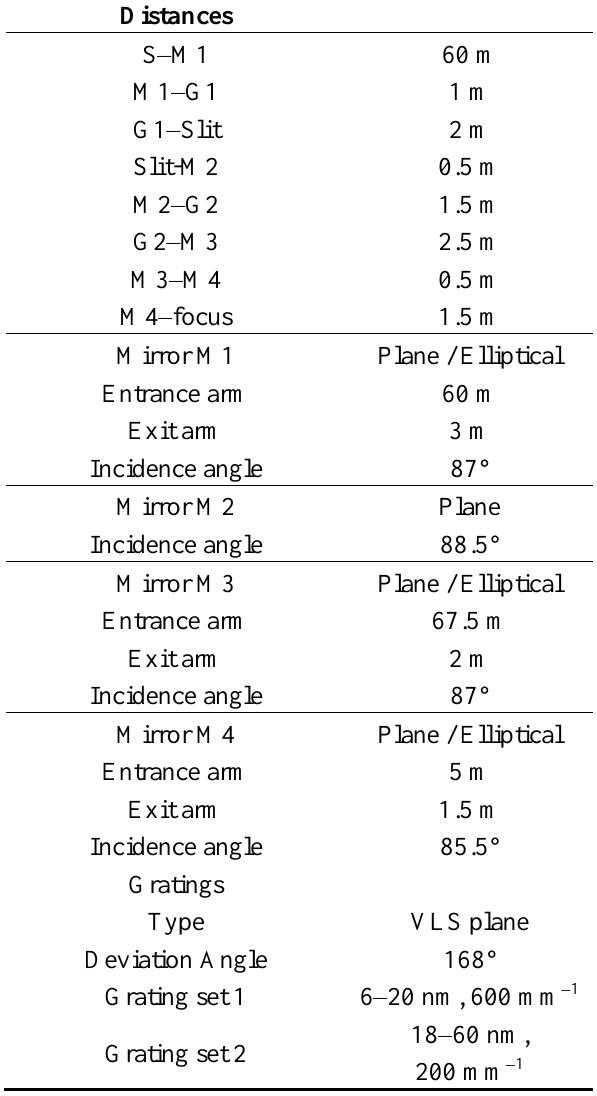
Table 3. Parameters of the beamline for FLASH